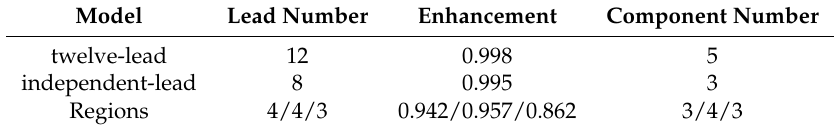
Figure 8. Different measurements for PCA over lateral heart region. ( a ) Distribution of ρ RMSE coefficient for each independent component, values lower than zero represents cases where the RMSE measured over the ECG is greater than RMSE measured over the independent component. ( b ) Ratio of fragmentation wave enhancement for each independent component, this ratio is computed as cases where the ρ RMSE value is greater than zero. ( c ) Cumulative ratio of fragmentation wave enhancement, this ratio is computed by joining the results of isolated independent components. Table 4. Summary table with the relevant values for each proposed method based on PCA.